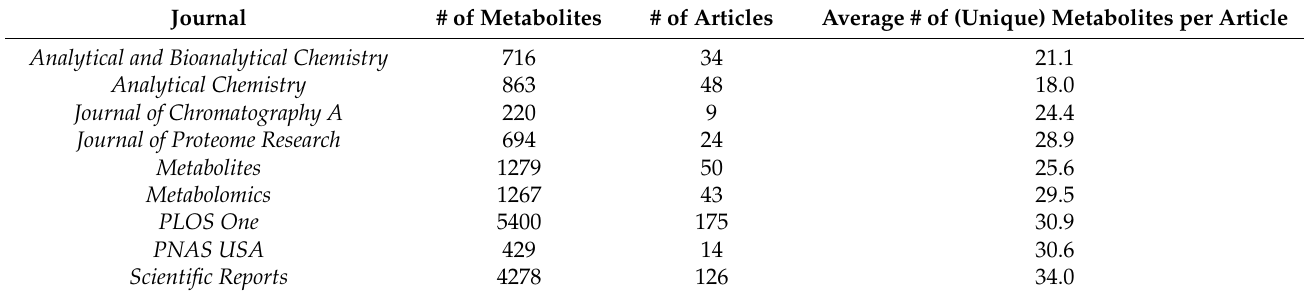
Table 1. Summary of number (#) of unique metabolites mentioned per journal. Each metabolite is only counted once per article.